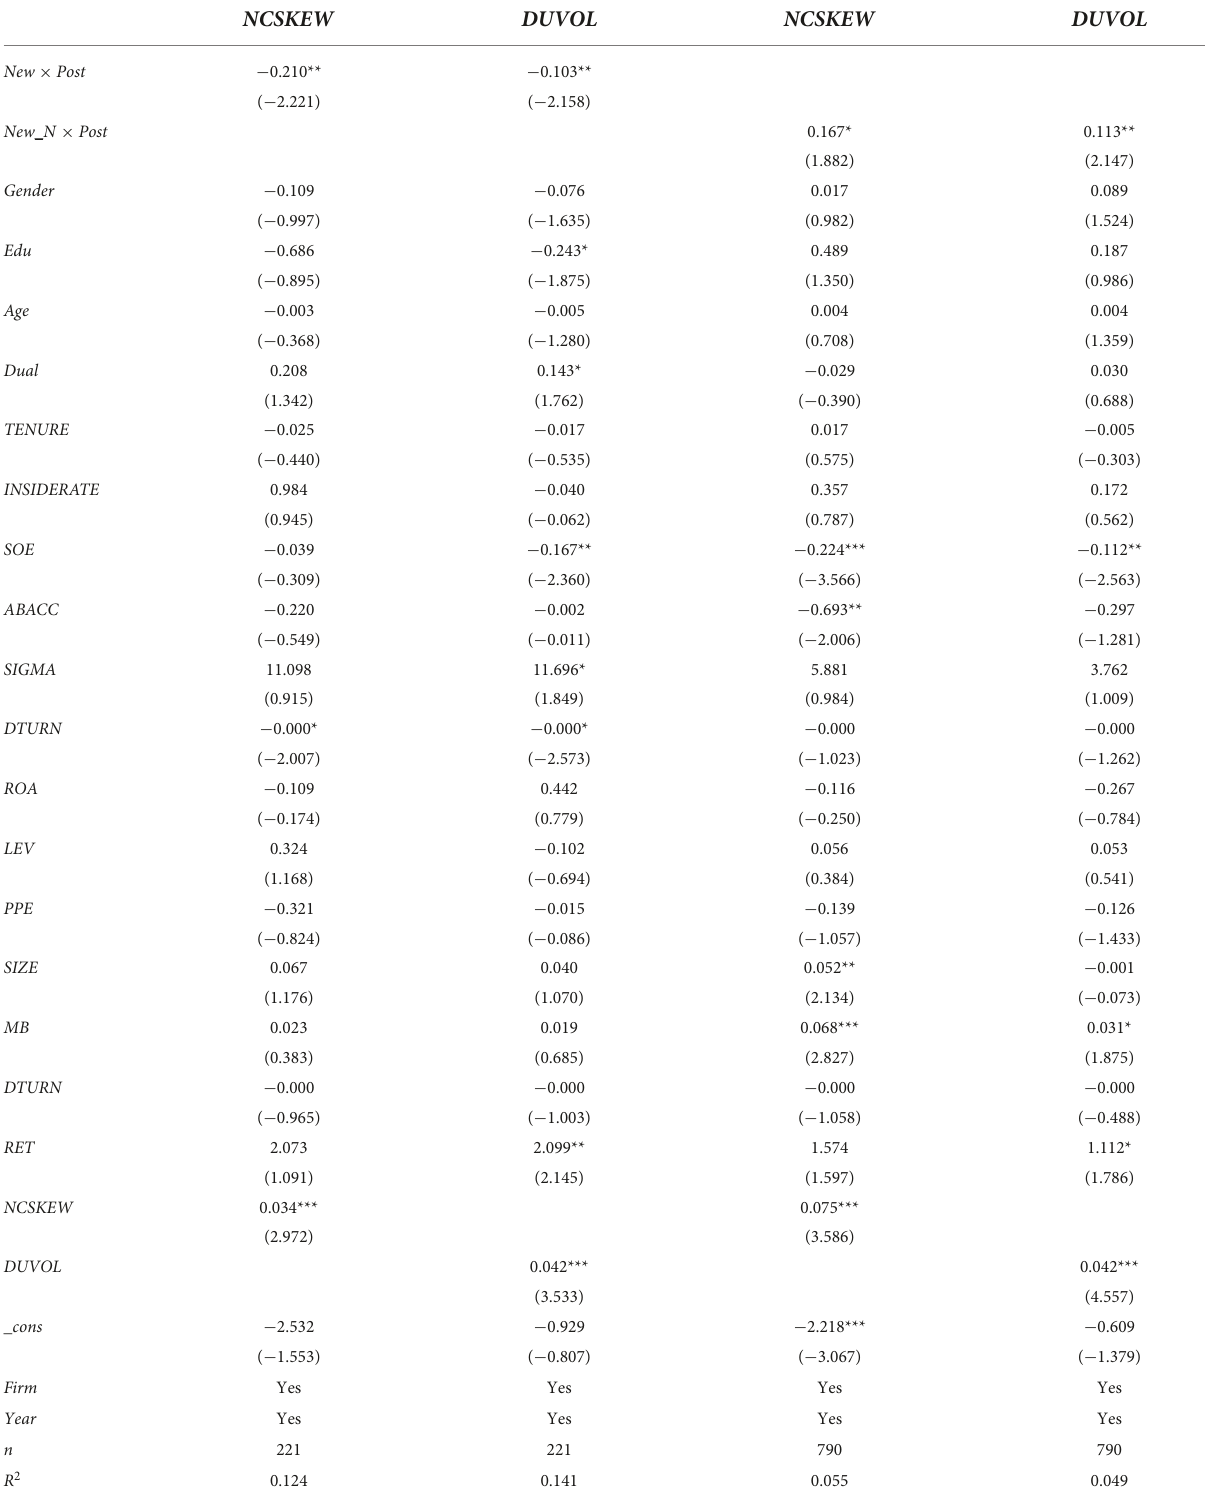
TABLE 9 Difference-in-differences